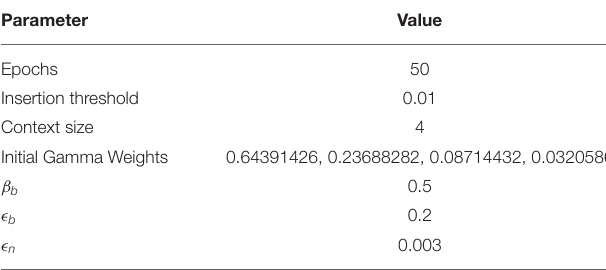
TABLE 3 | Training parameters of the self-organizing temporal binding